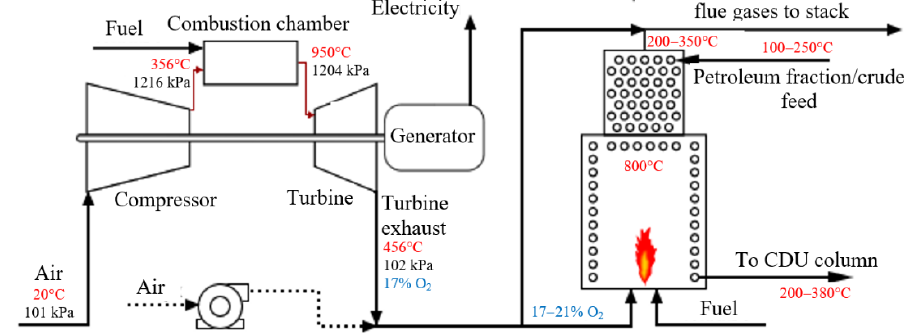
Figure 1. Illustration of a gas turbine integrated with a furnace for crude distillation unit.